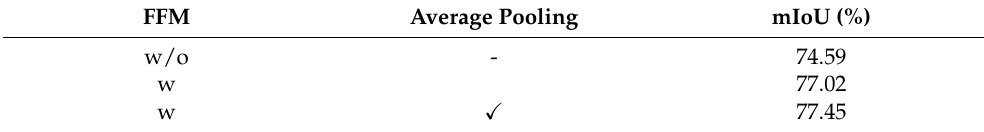
Table 6. Results of the FFM module with different components. n = 2 , m = 4, l = 4.